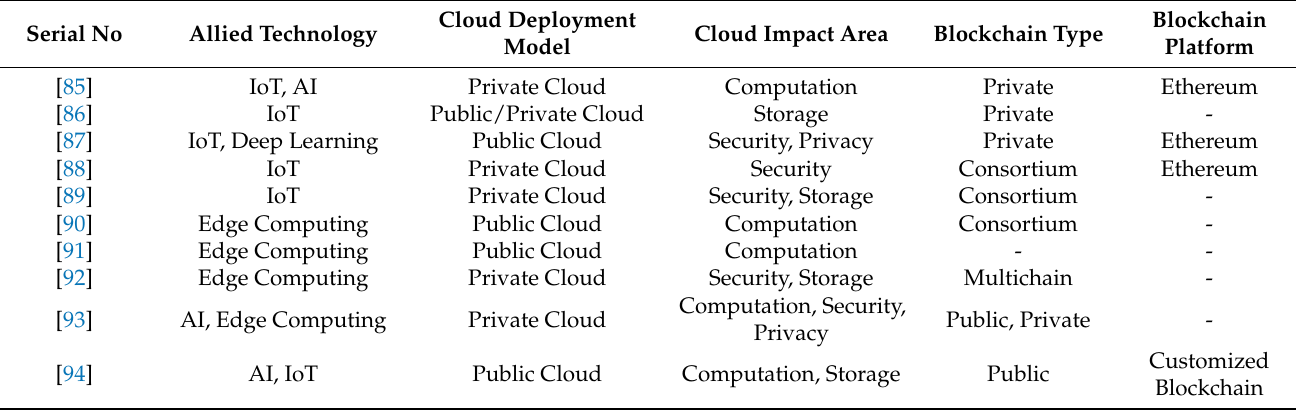
Table 3. Blockchain–Cloud Integration with Allied